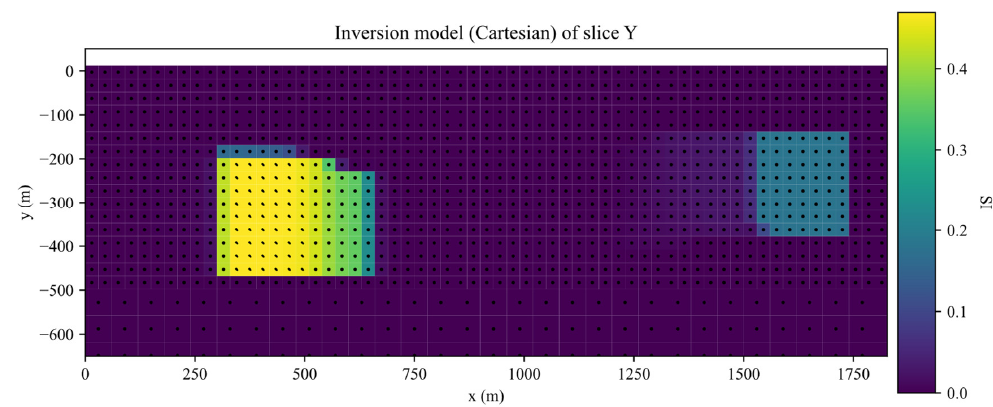
Figure 14. Slices along the Y planes of inverted Galinge iron ore deposit.